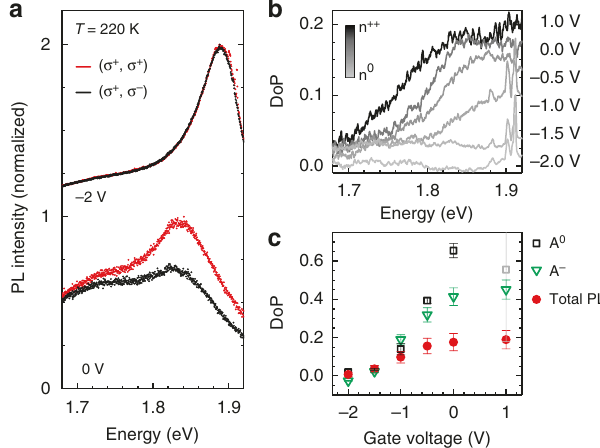
Fig. 1 Valley polarization in dependence of the electron density. a Circularly polarized PL spectra for σ + excitation and σ + (co-polarized) and σ − (cross- polarized) detection measured with E i = 1.96 eV and at T = 220 K for two different gate voltages of a 1L-MoS 2 device with ionic liquid top gate. Spectra are normalized to the maximum of the respective co-polarized spectrum. The absolute intensity of the spectra for − 2 V is a factor of 10 higher than for the spectra taken for 0 V. b Spectrally resolved degree of polarization for a series of gate voltages. Negative (positive) gate voltages correspond to electron depletion (accumulation). c Degree of polarization as a function of the applied top gate voltage of the total PL signal as shown in b evaluated at the PL peak maxima, and of the individual contributions of the neutral (A 0 ) and charged (A − ) exciton obtained from peak fi ts. The error bars denote the standard deviation from the fi t